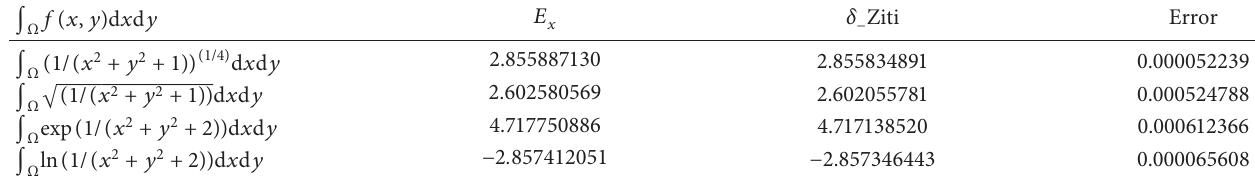
− ziti and the exact value in the Cartesian case.